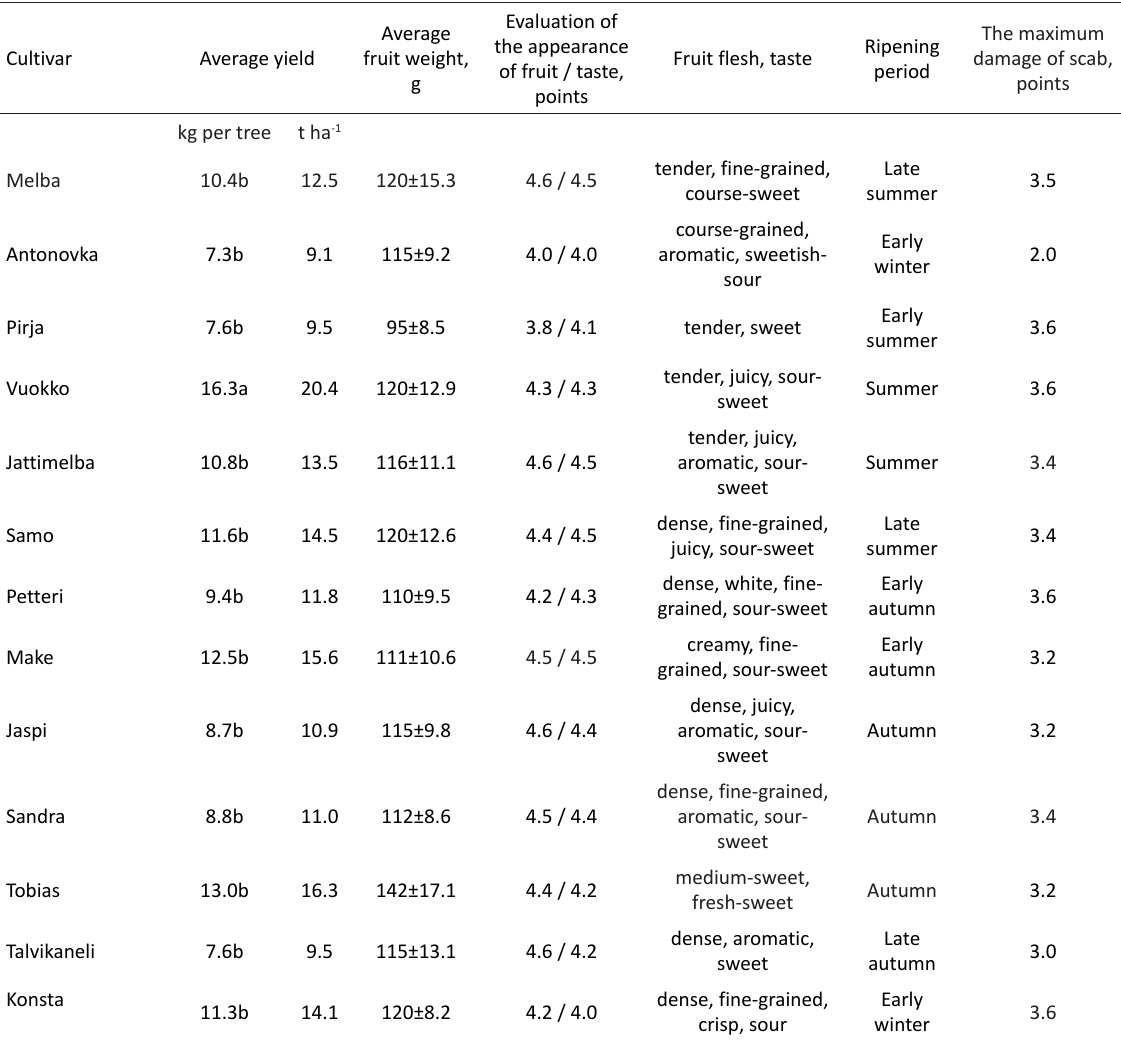
Table 4. Productivity, scab damage and fruit quality of apple cultivars (2015–2018) Cultivar Average yield